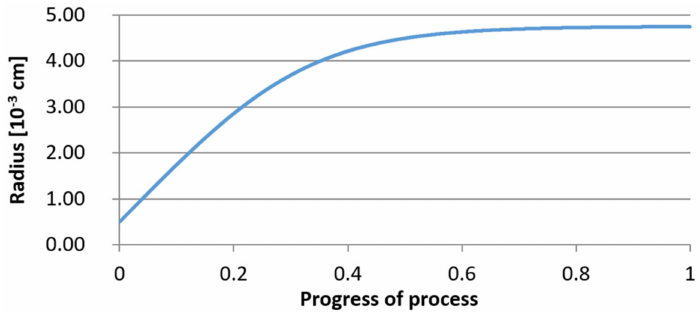
Figure 17. Increase of nucleus radius (with initial radius r 0 = 5 µ m) in steel 1.